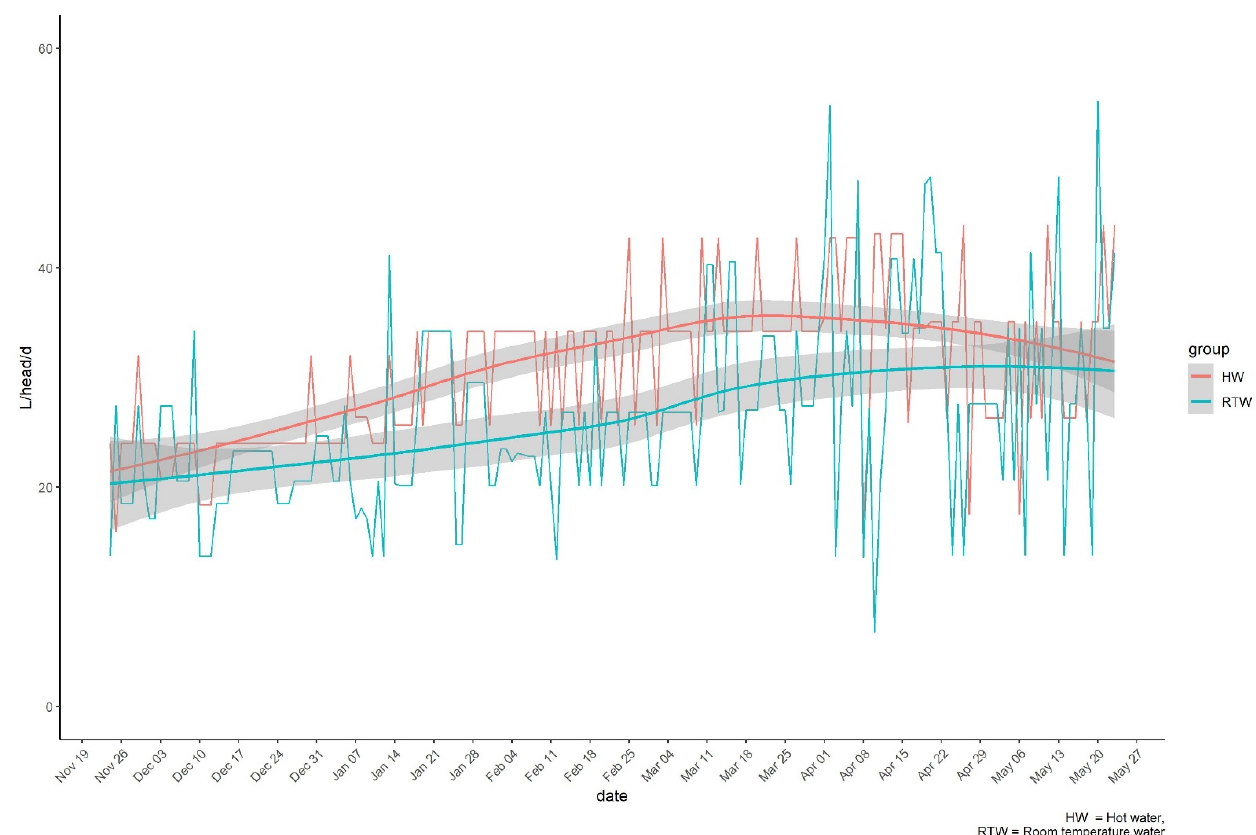
Figure 2. Trends in individual water consumption (L/head/d) during the trial in HW and RTW groups .